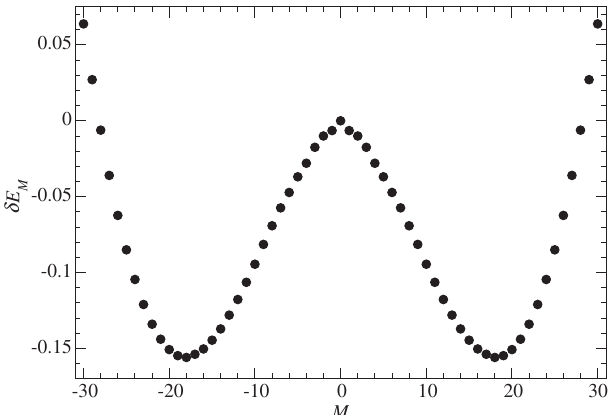
FIG. 5. Lowest two-particle energy for fixed M relative to the M ¼ 0 state δ E M . We here consider α ¼ 30 and M [Eq. (37)] vs λ ¼ 1 , where δ E ℏ ω M is given in units of